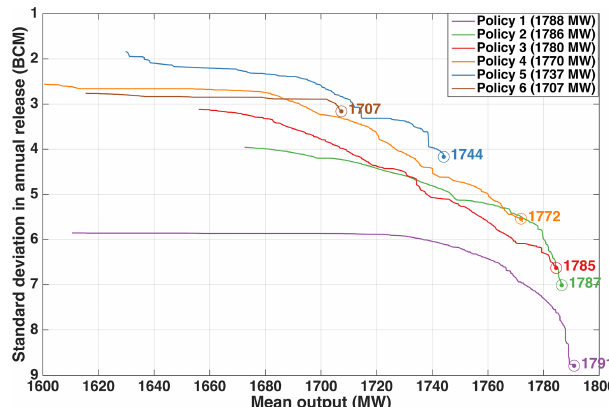
Figure 8. Percentiles of annual reservoir inflow and water release under various power generation levels.